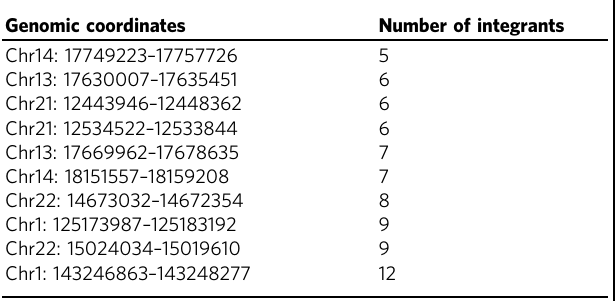
Table 2 Hot spots of integration for viruses carrying the K258R IN